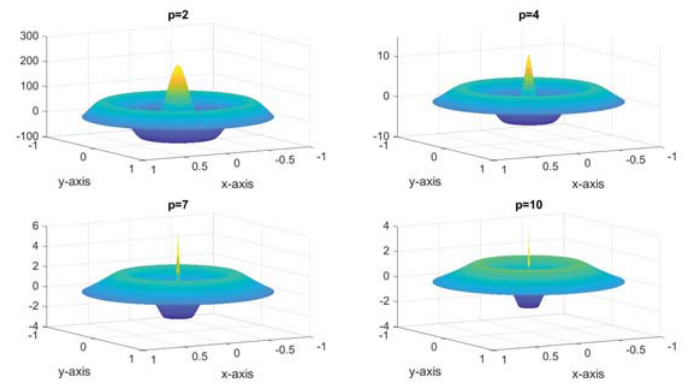
Fig. 2: Radially symmetric numerical solutions with three nodal regions